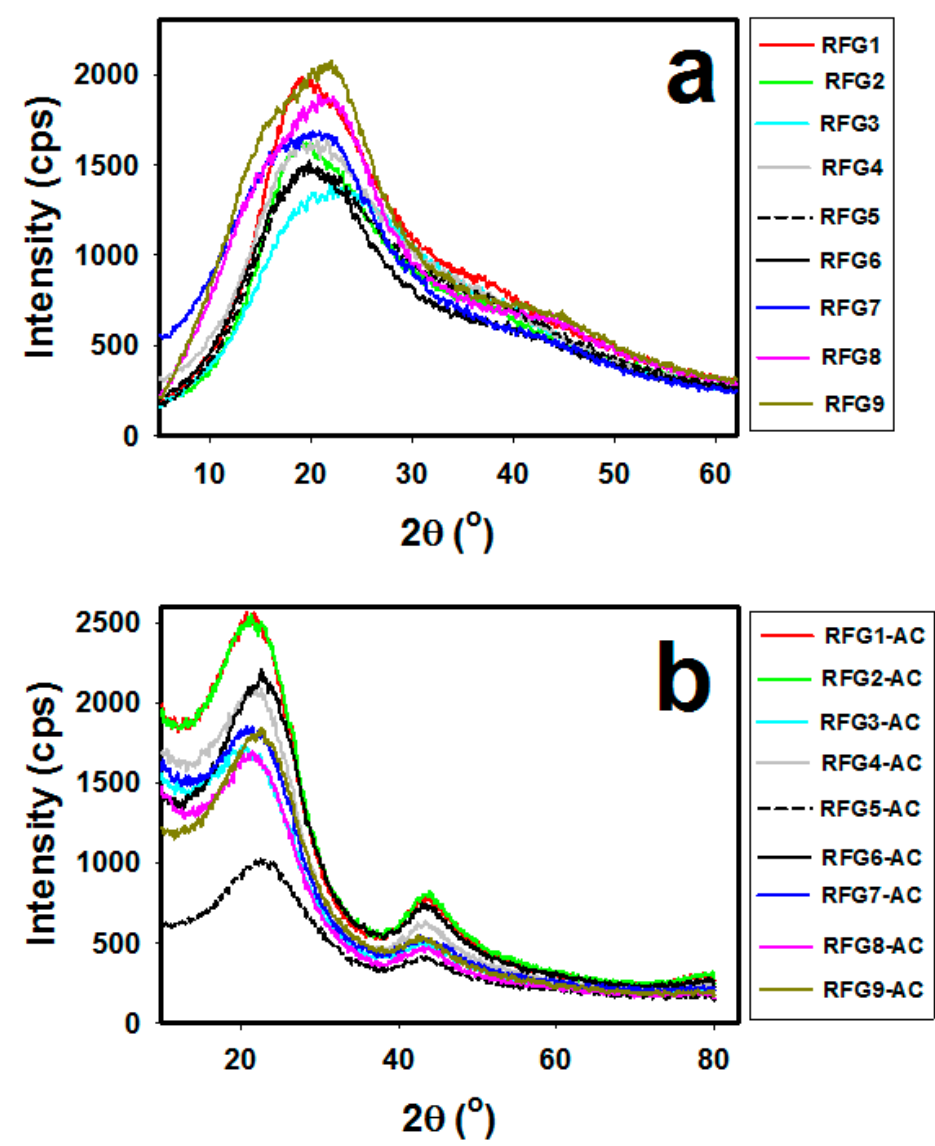
Figure 5. XRD patterns of ( a ) RFG n and ( b ) RFG n -AC samples.